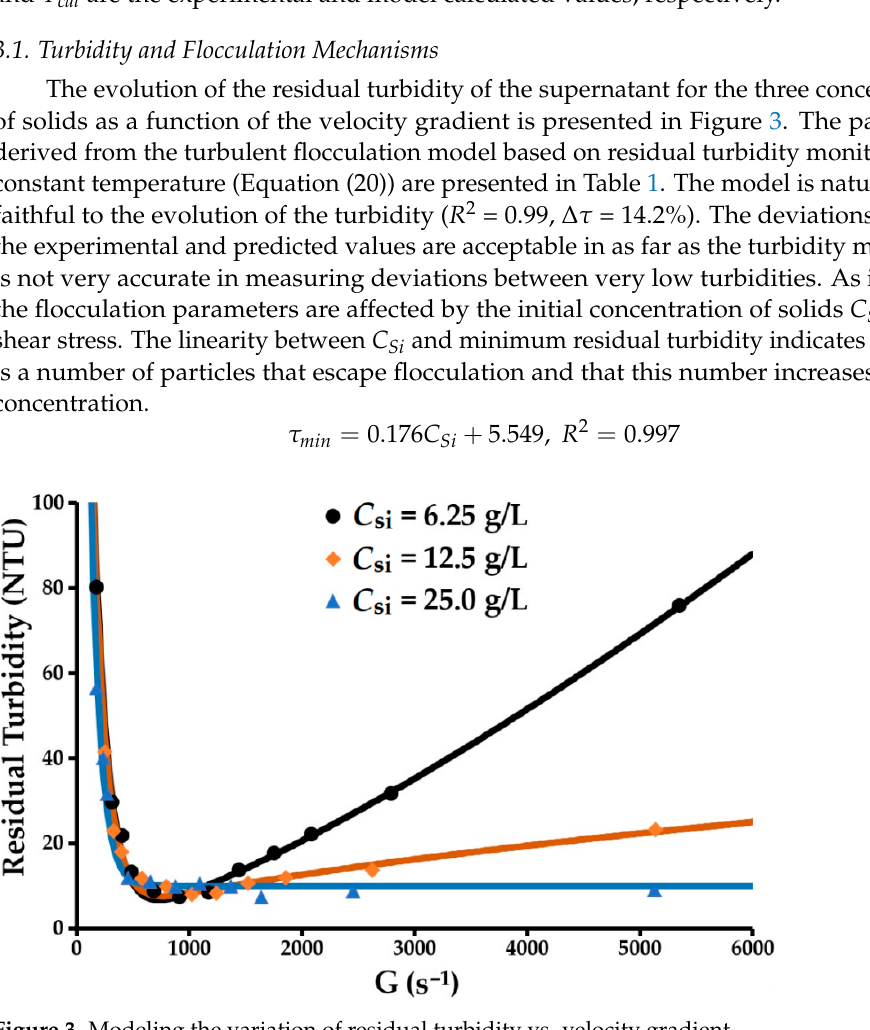
Table 1. Results of applying the proposed model to the analysis of residual turbidity variation with velocity gradient.